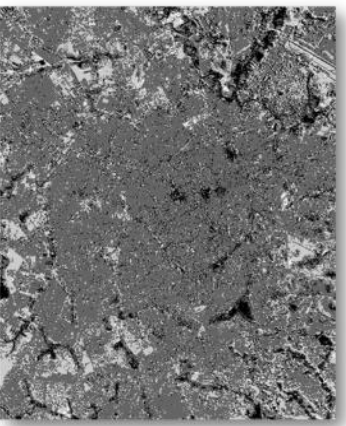
Figure 9 – NDVI_Dif image: difference between RAINY NDVI and DRY NDVI images.